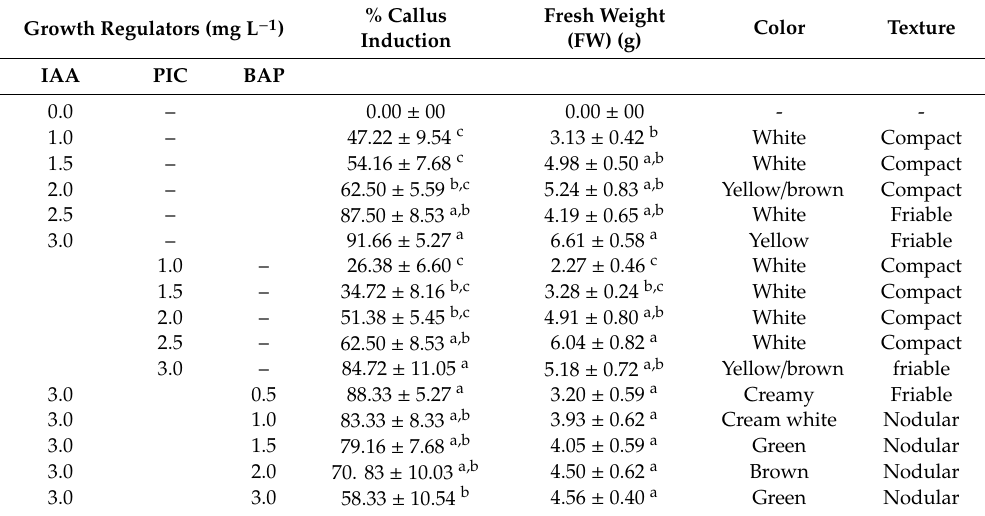
Figure 4. In vitro shoot multiplication from at di ff erent subculture stages. ( A ) Individual shoot used for shoot induction and multiplication; ( B ) and ( C ) maximum number of shoots per explant obtained with 3-mg L − 1 BAP after four weeks; ( D ) highest shoot length obtained with 3-mg L − 1 TDZ. Bar = 1 cm. Table 4. Influence of auxins alone and in combination with cytokinins on callus induction from Alocasia longiloba seed.